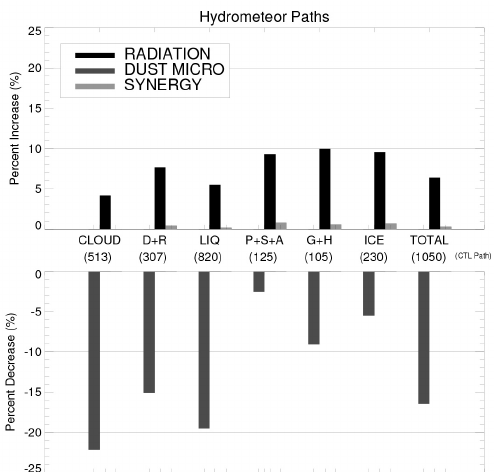
Fig. 9. Horizontally averaged, vertically integrated mixing ratios of various hydrometeors, referred to in the text as hydrometeor paths (g m − 2 ) . The hydrometeor paths are expressed as a percent contri- bution to CONTROL by RADIATION (black bars), DUST MICRO (gray bars), and SYNERGY (light gray bars). D + R is drizzle and rain, P + S + A pristine ice and snow and aggregates, and G + H grau- pel and hail. The numbers below each hydrometeor group are the full field path value for CONTROL.